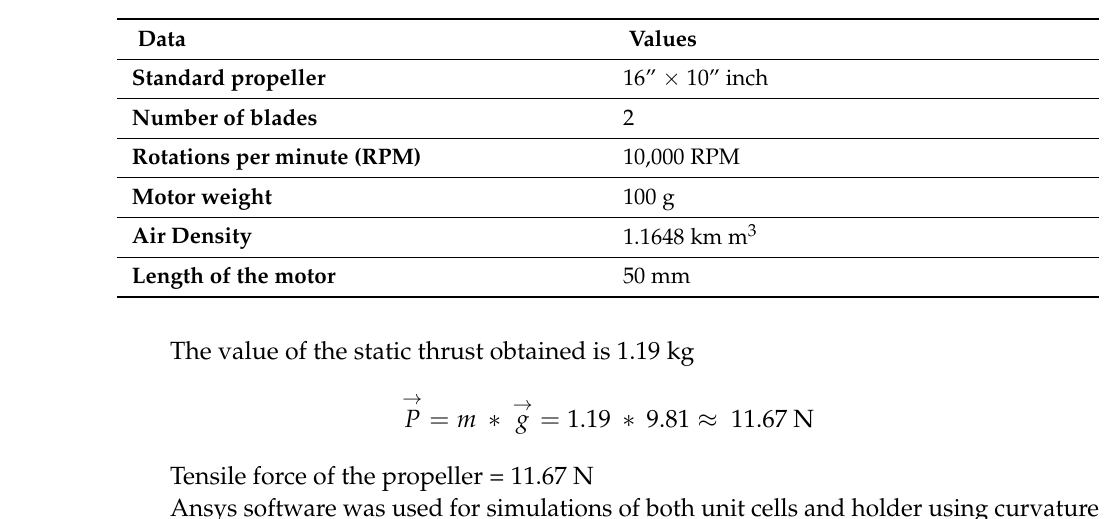
Table 4. Values used to calculate the static thrust.